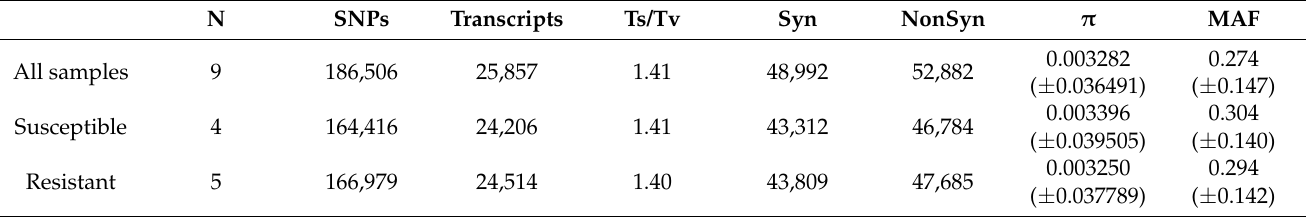
Table 1. Number of SNPs and genetic diversity estimates for all samples, for pinewood nematode susceptible samples, and for resistant